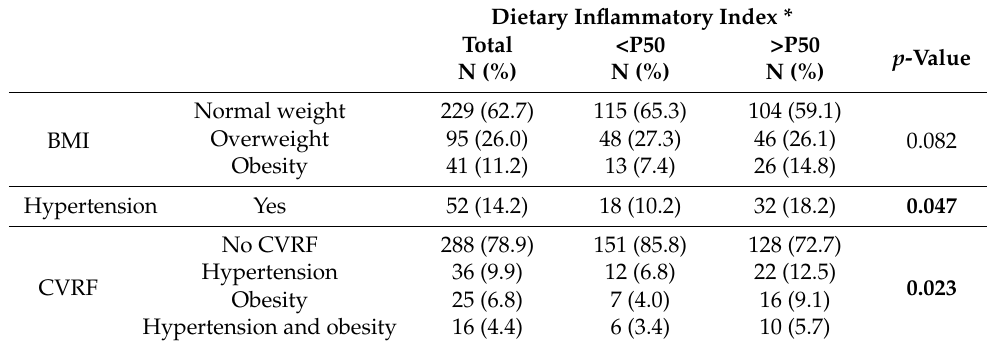
Table 5. Dietary Inflammatory Index relation with a prevalence of Cardiovascular Risk